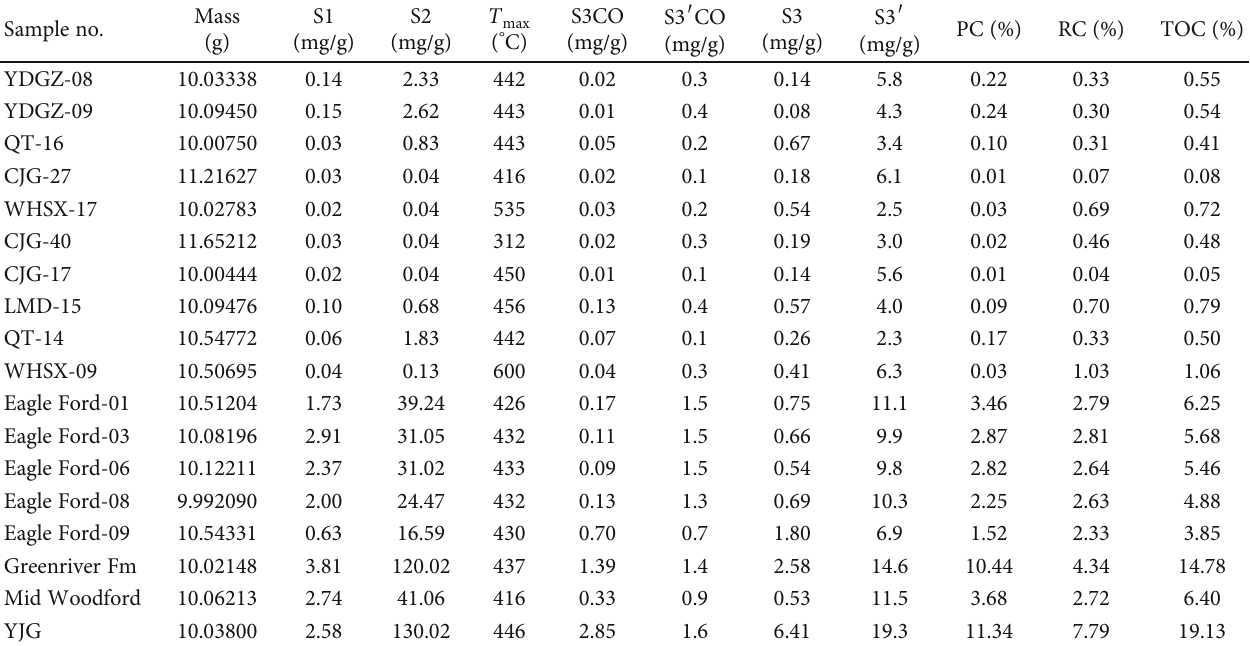
Table 1: The results of rock-eval pyrolysis for bulk rock samples. Sample